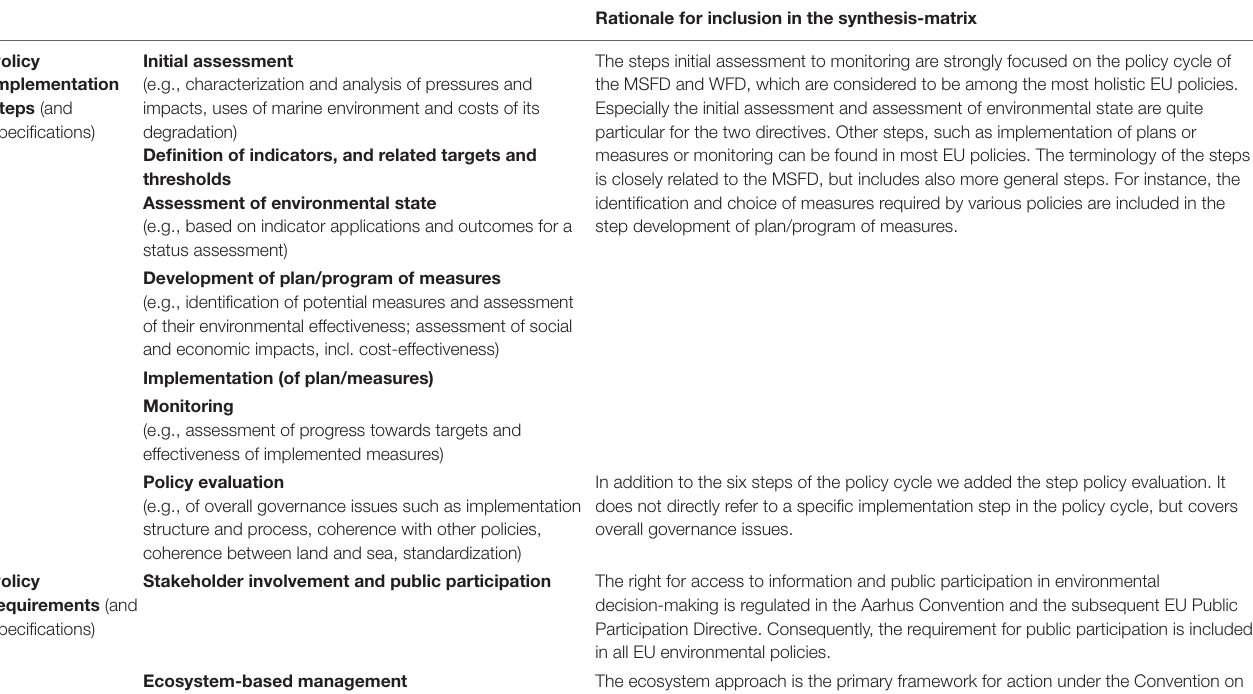
TABLE 3 | General policy implementation steps and requirements that resulted from the policy review and rationales for the inclusion in the